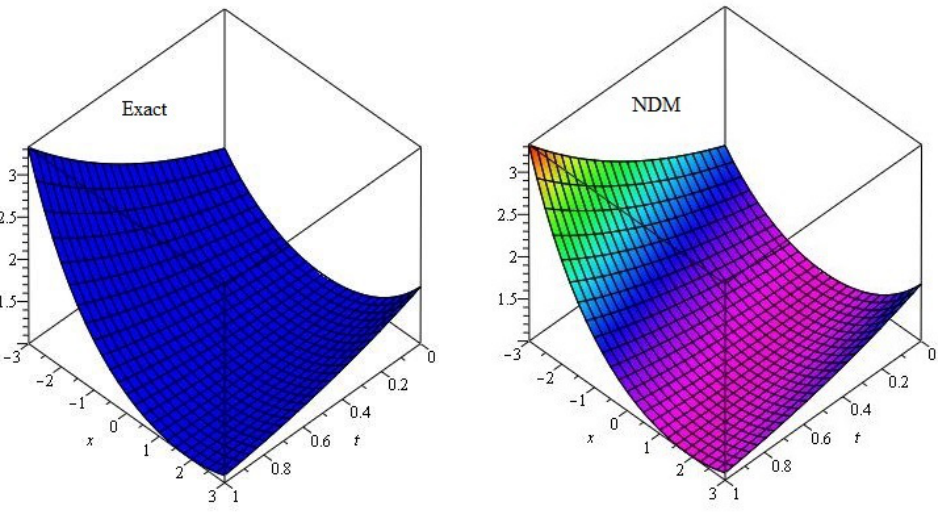
Figure 5. The graph of exact and approximate solution of Example